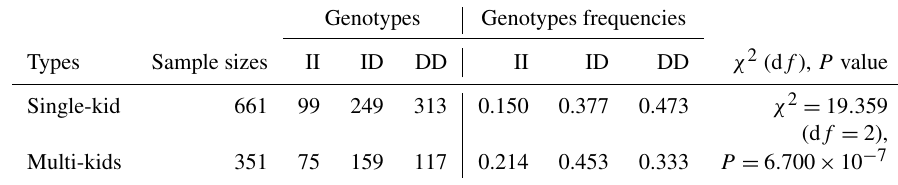
Table 3. Genotypic distribution between mothers of single-kid and multi-kid Shaanbei white cashmere (SBWC) goats.